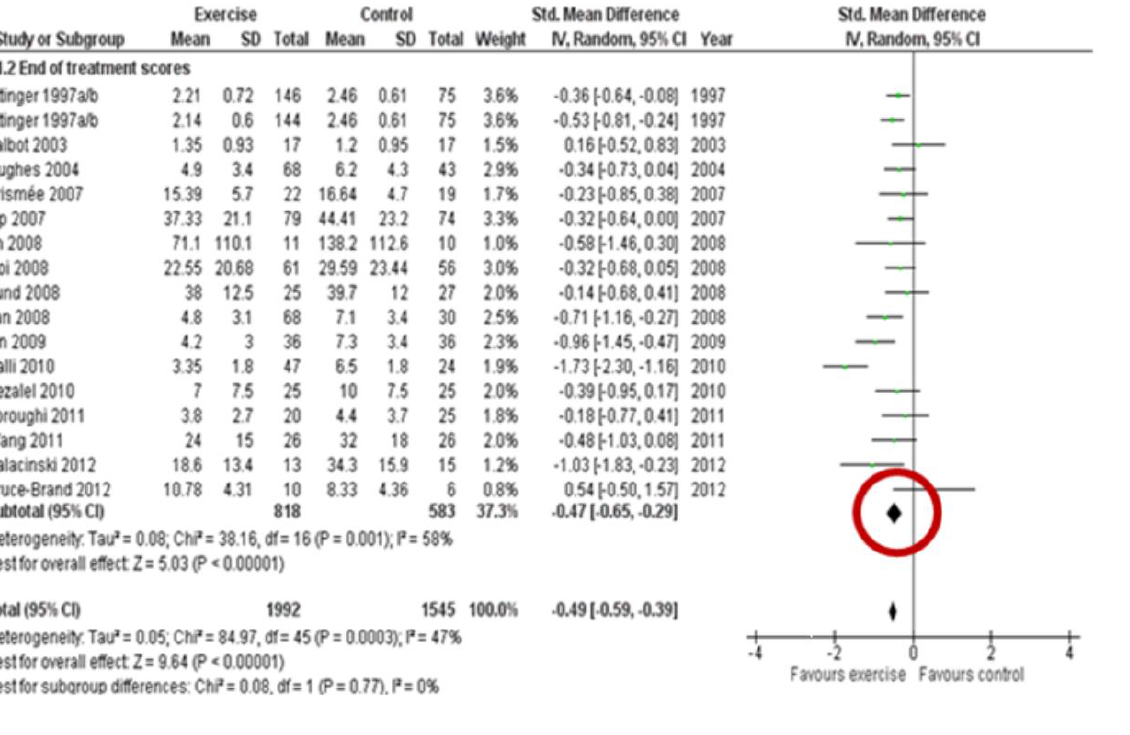
Control Standard Mean Difference Standard Mean Difference Exercise